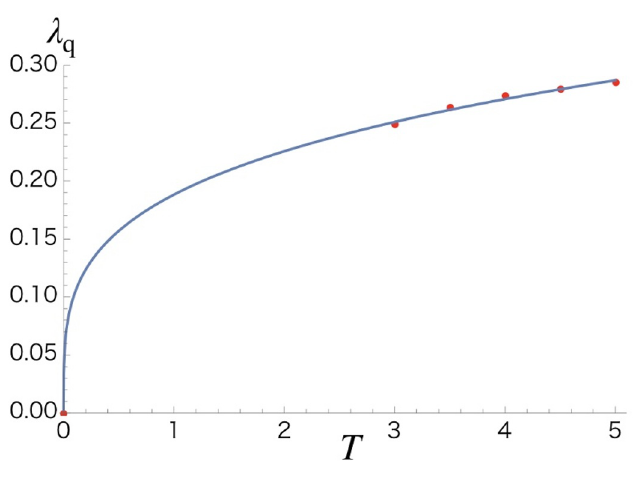
Figure 7 . Measured quantum Lyapunov exponent as a function of temperature, and its (cid:12)tting